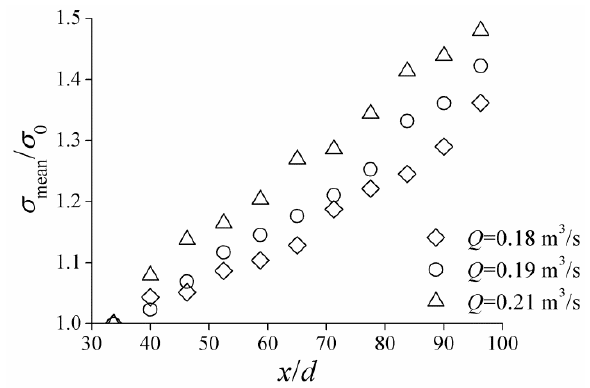
Figure 10. Dimensionless distributions of flow fluctuation at x direction along the flow direction.